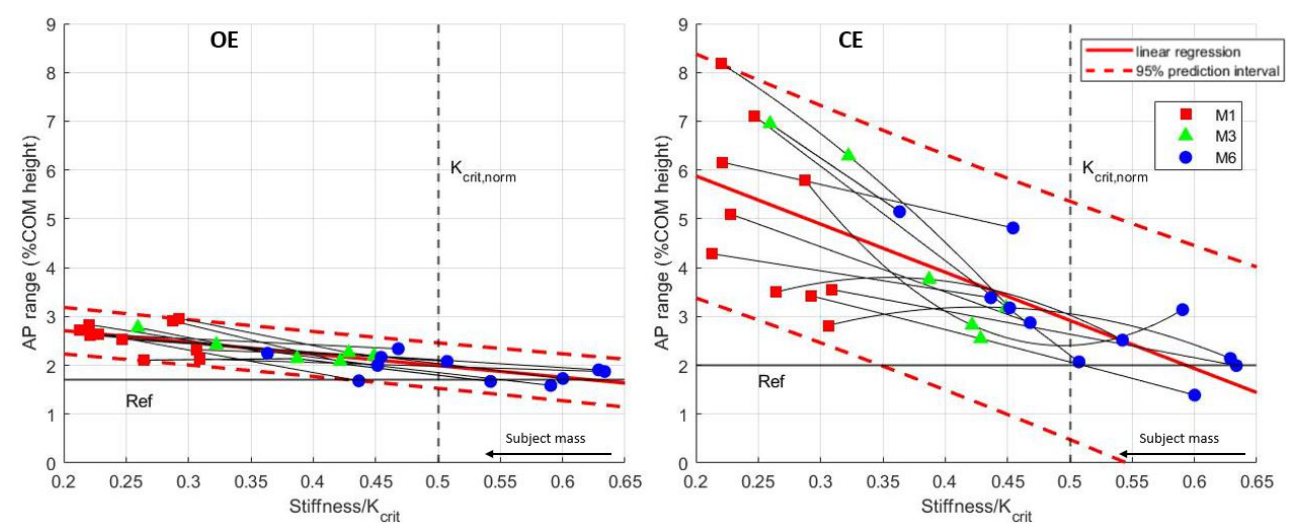
Figure 5. AP range normalized by the COM height against the foot stiffness normalized by the critical stiffness K crit = m tot gh COM in the OE ( left ) and CE ( right )